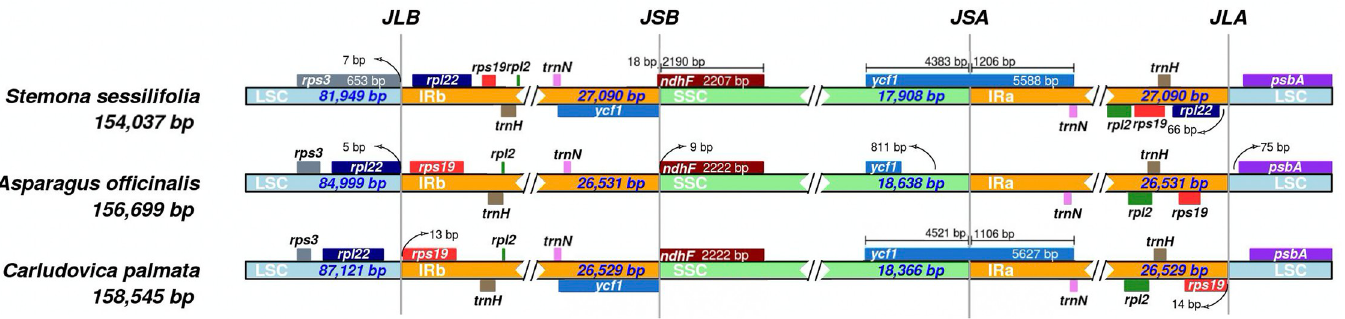
Fig 5. Comparison of IR, LSC and SSC regions among Stemona sessilifolia , Carludovica palmata and Asparagus officinalis . The numbers above, below or adjacent to genes represent the length of genes or the distances from the front or end of genes to the boundary sites. It should be pointed out that the figure features are not to scale.